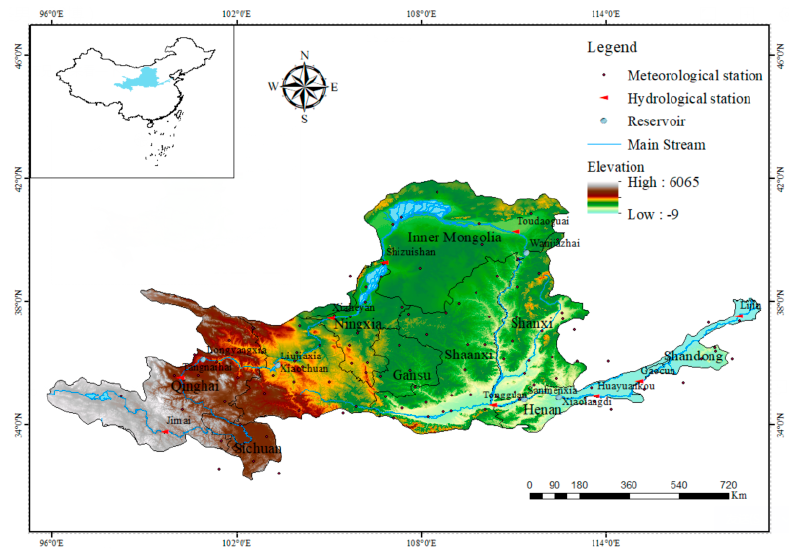
Figure 2. The geographical location of the Yellow River Basin, provinces, and hydrological and meteorological stations from where data were obtained for this study.